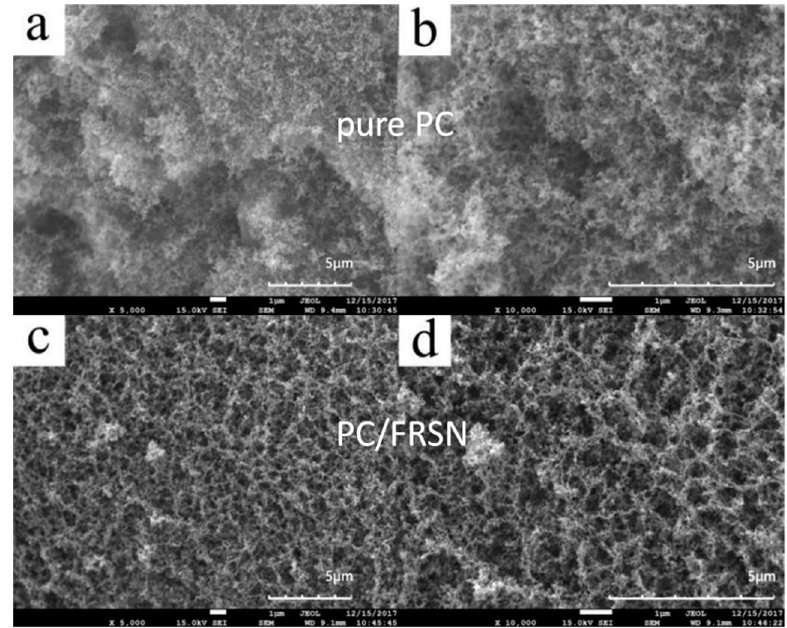
Figure 4. SEM micrographs at different magnifications of the residual char of ( a – b ) PC and ( c – d ) PC/FRSN after UL 94 vertical burning test.